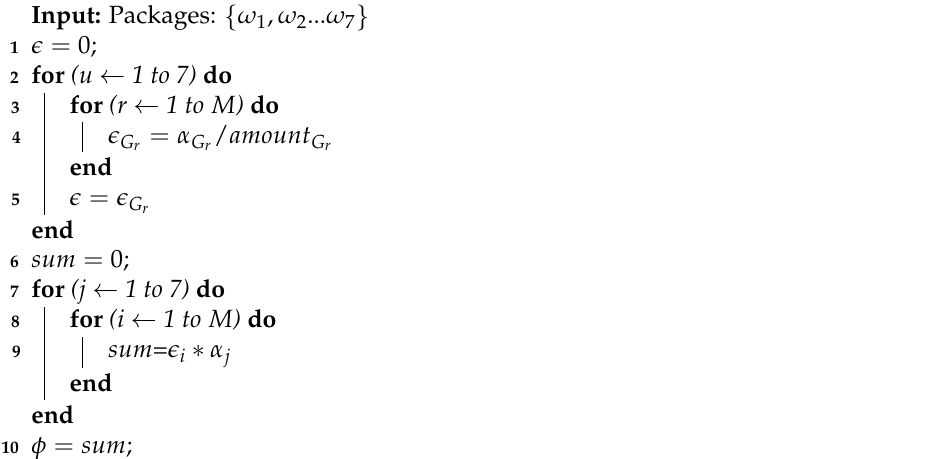
Algorithm 2: Medical benefit computation using generated packages.